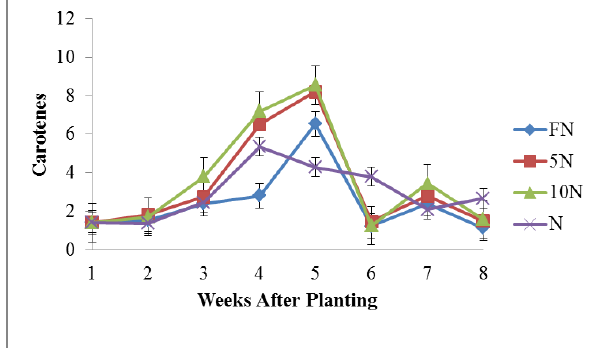
Fig. 3a. The effect of nitrogen nutritional stress on the total chlorophyll accumulation of Vigna unguiculata measured at dif- ferent periods